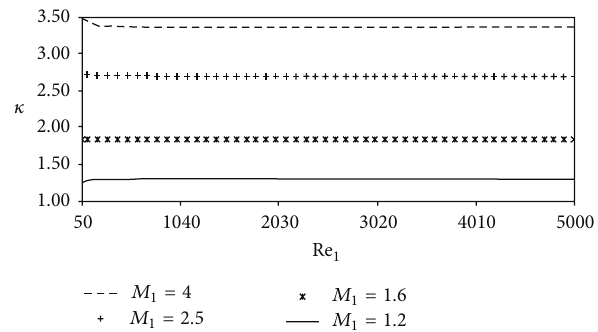
Figure8:Variationsofcompressionrateasafunctionof Re 1 atfour different upstream Mach number values.